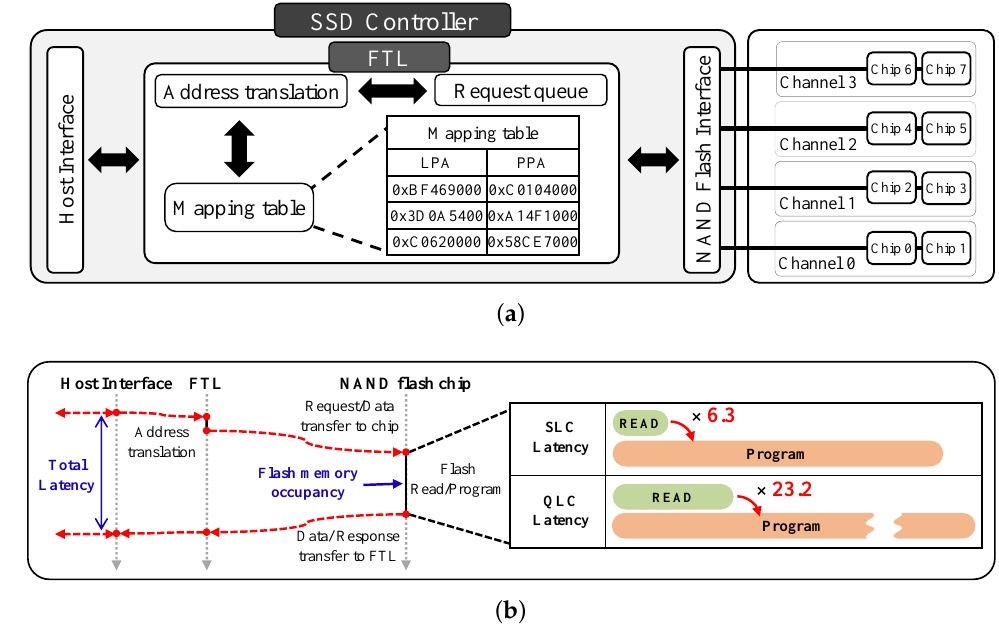
Figure 1. ( a ) Data flow across the components in the simplified SSD structure; ( b ) timing diagram for a request flow from host to